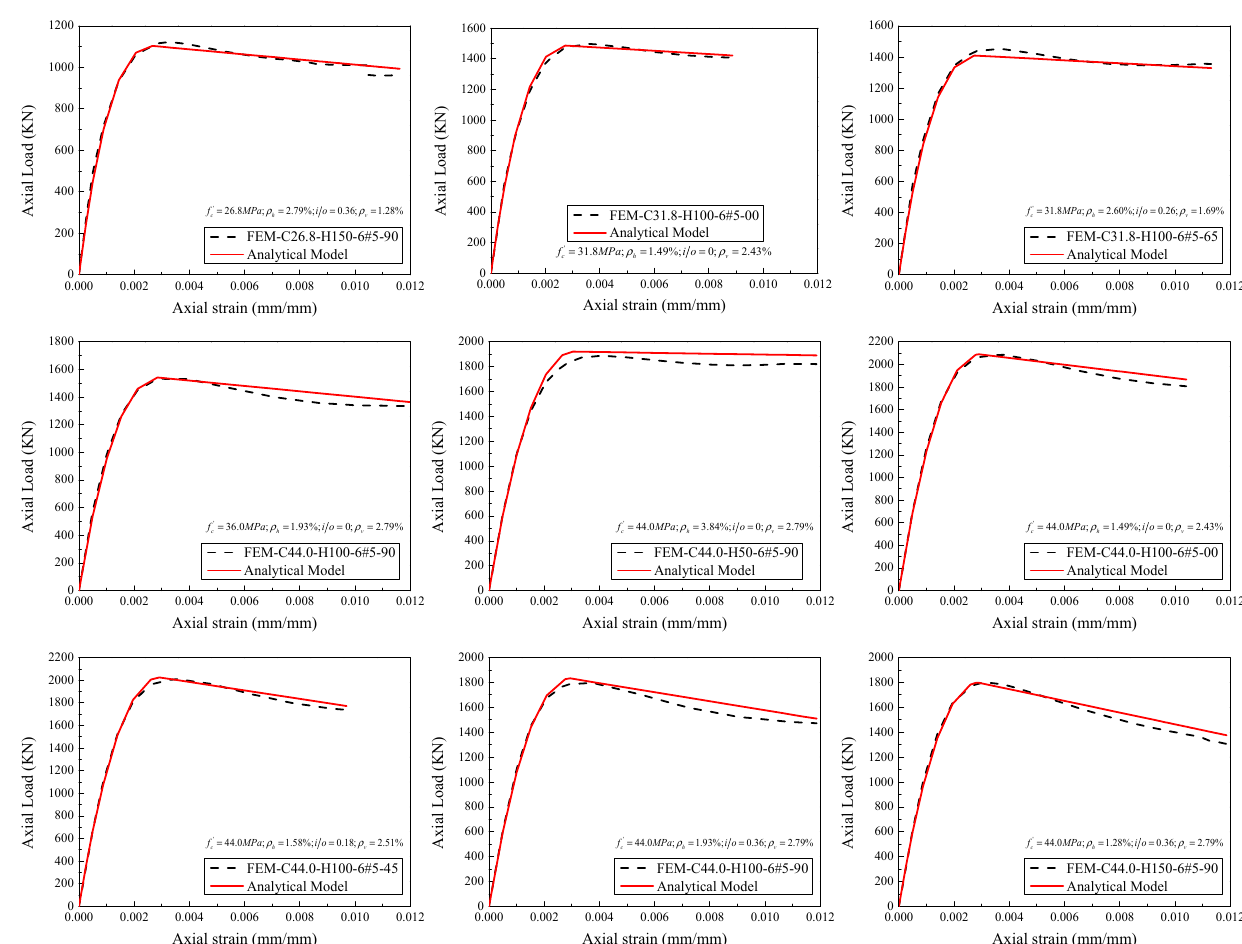
Figure 24. Comparison between predictions of proposed concrete axial load-axial strain curves, and experimental and numerical results.